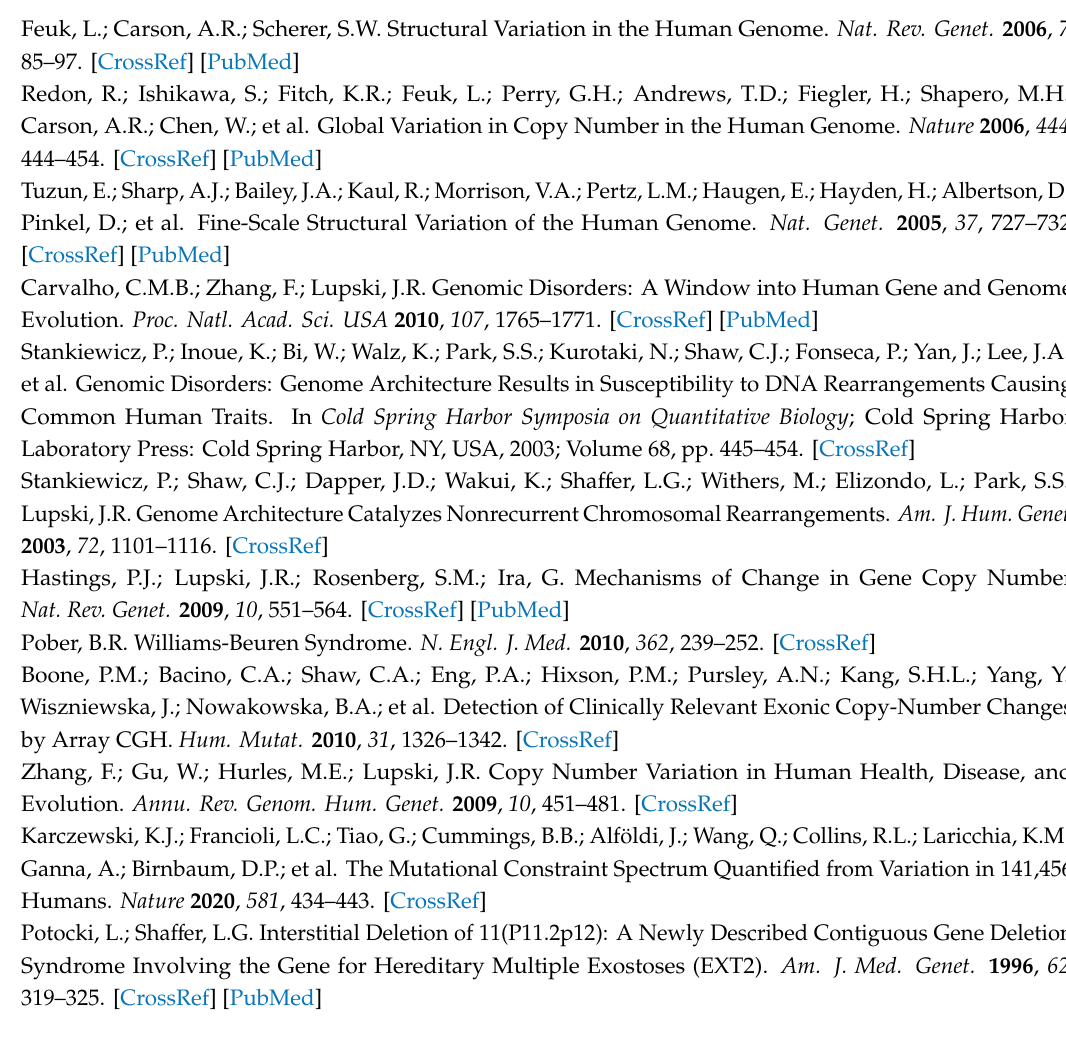
phenotype; Supplementary Table S2: Summary statistics of the clinical presentation. Supplementary Table S3: Dysmorphic